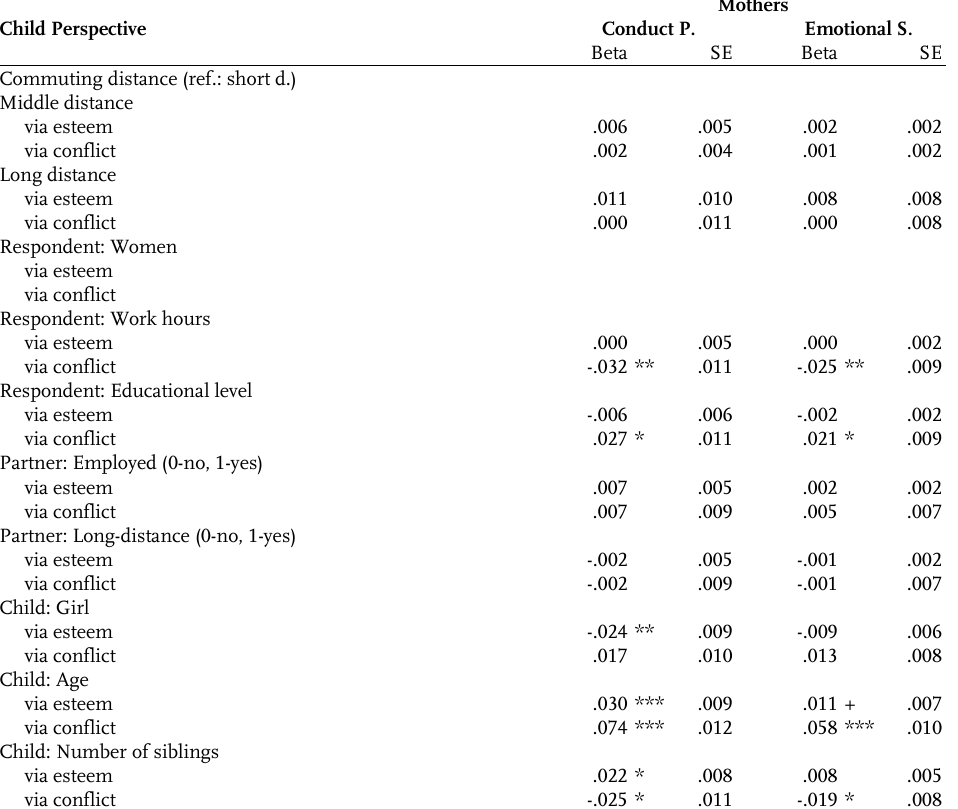
Mothers Beta SE Beta SE